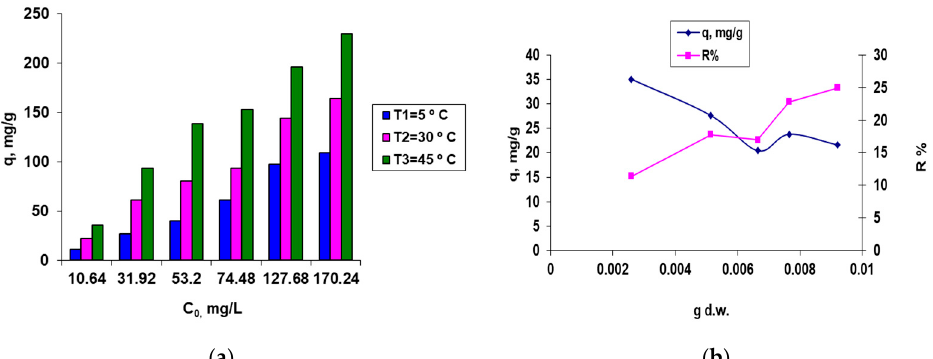
Figure 2. The influence of the initial dye concentration and solution temperature ( a ) and the quantity of biosorbent per 25 mL aqueous dye solution ( b ) on the biosorption of Brilliant Red HE-3B dye onto the residual microbial biomass of S. pastorianus immobilized in sodium alginate. Conditions: pH = 3; T = 25 °C; contact time = 24 h; 2.6 g/L biosorbent ( a ) and C 0 = 31.95 mg/L ( b ).